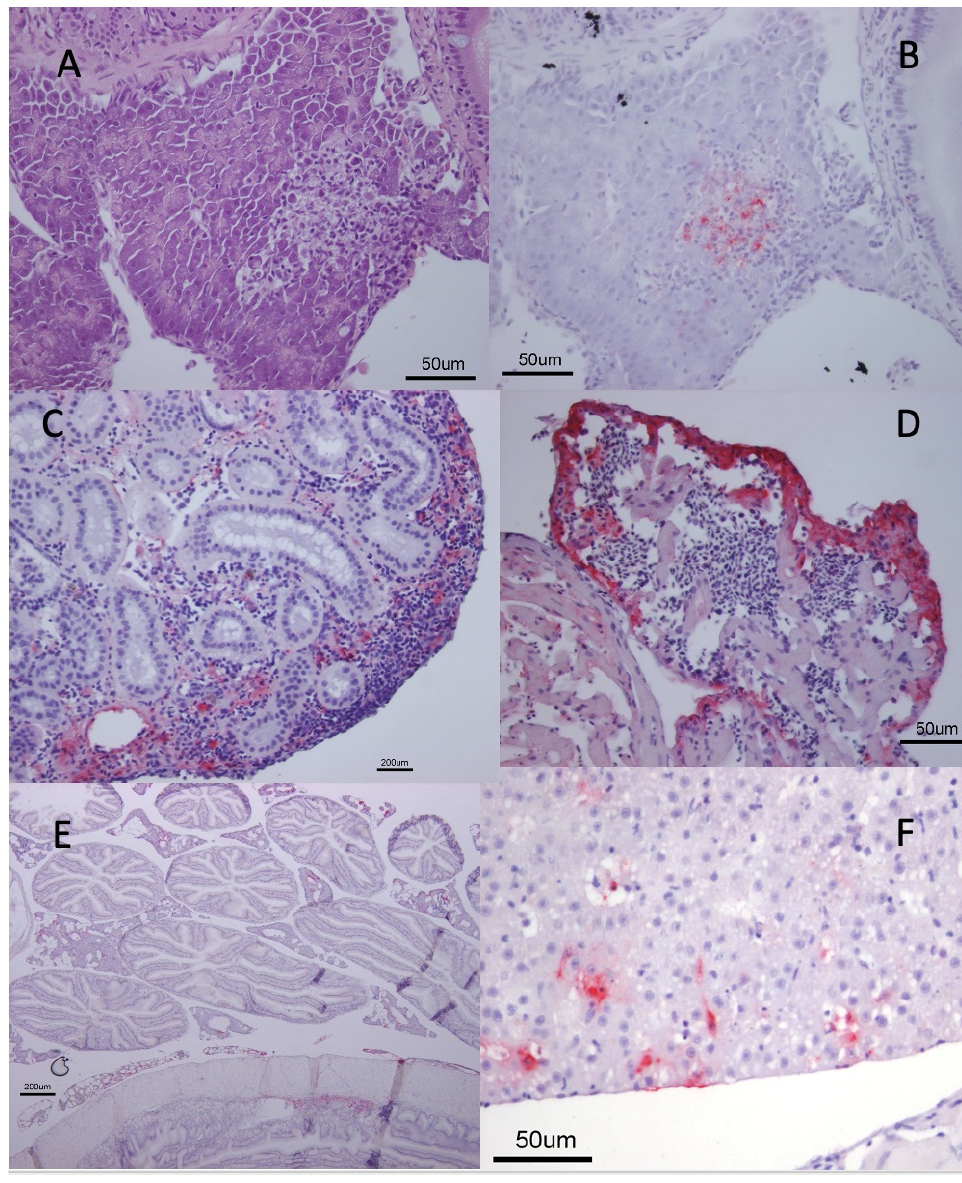
Figure 4. Haematoxylin staining ( A ) and immunohistochemistry (IHC) ( B – F ) of tissue samples from Atlantic herring challenged with VHSV genotype III 4p168 ( A – C ) or the VHSV genotype Ib isolate NO F-CH/2009 ( D – F ). ( A ) Necrosis in pancreas. ( B ) IHC of the same tissue as in ( A ), showing positive immunostaining in the area where necrosis is seen. ( C ) Kidney of the same individual as in ( A , B ) shows positive immunohistochemistry in the hematopoietic tissue. ( D ) Heart, showing positive IHC in the outer rim of the atrium and in lumen of the ventricle. ( E ) Overview of the abdominal cavity, showing intestine, pancreas, and pylorus. Positive staining in pancreas. ( F ). Positive IHC of hepatocytes in liver. The larvae were sampled at day 7 PI ( A – C ), day 9 PI ( D , E ) and day 14 PI ( F ).